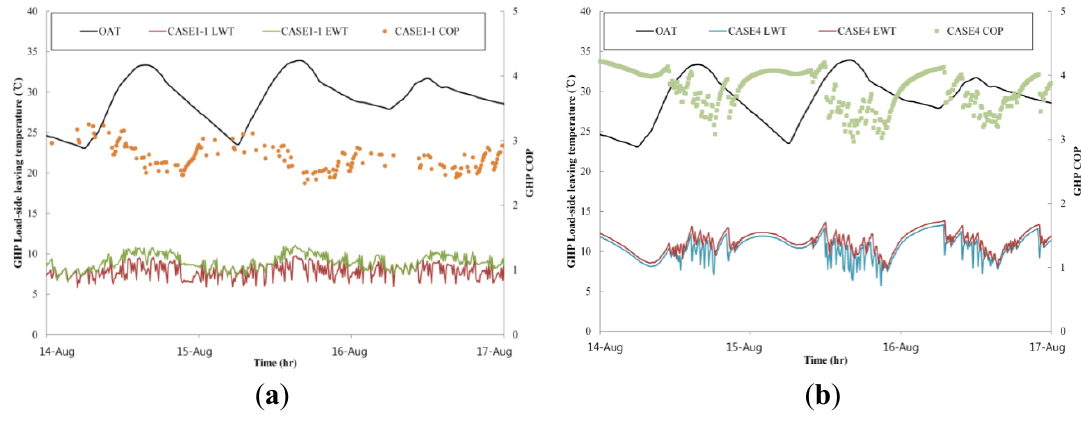
Figure 15. Coefficient of performance ( COP) and summer cold water inlet-outlet temperatures for the Multi-GHP system: ( a ) existing operation condition of Multi-GHP system (Case 1-1); ( b ) sequencing operation condition of Multi-GHP system (Case 1-2).